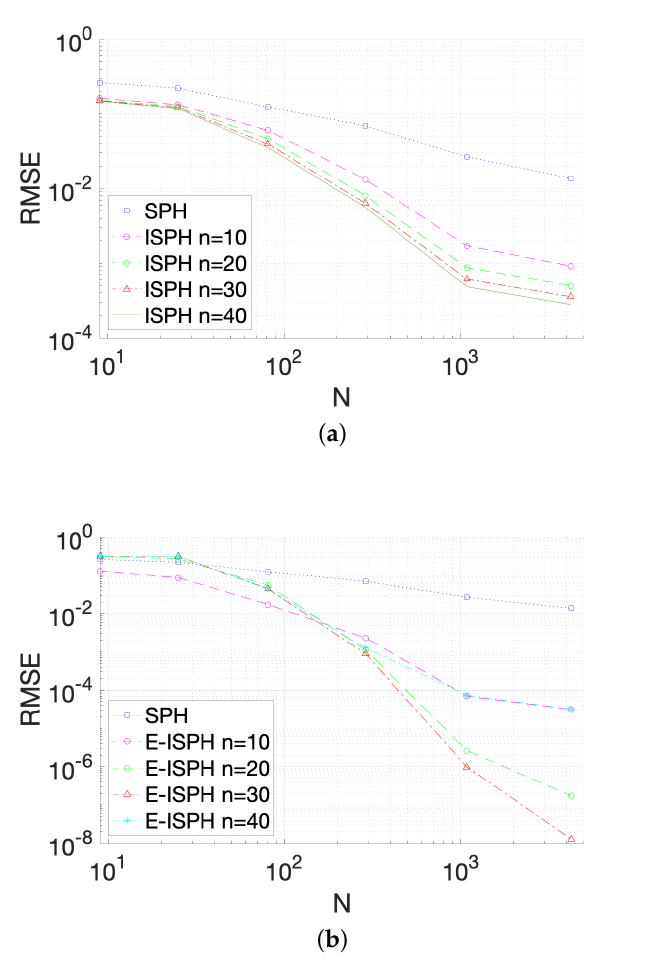
Figure 3. RMSEs versus number of data sites ( Ξ H ). ( a ) Comparison between SPH and ISPH; ( b ) comparison between SPH and E-ISPH. All the computations are with starting normalized values and 10 ≤ n ≤